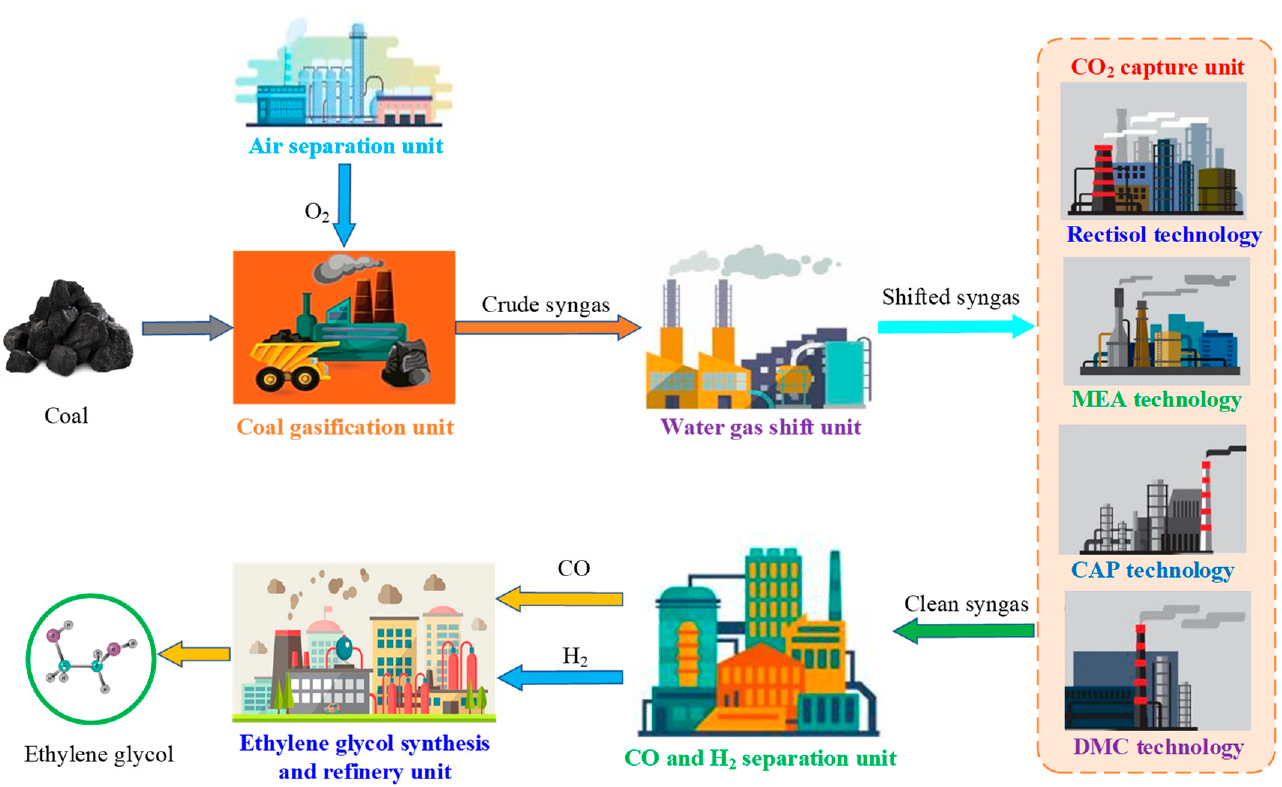
Figure 2. Schematic diagram of the CTEG process with different CO 2 capture technologies.